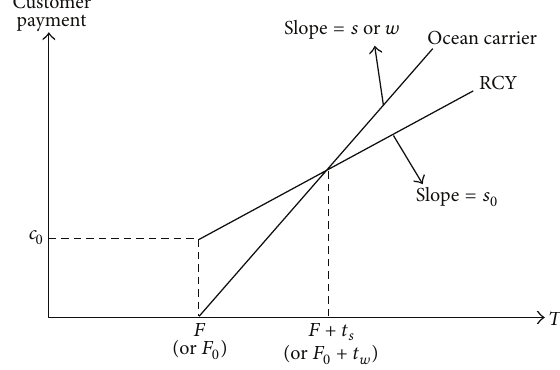
Figure 1: The payment function of the